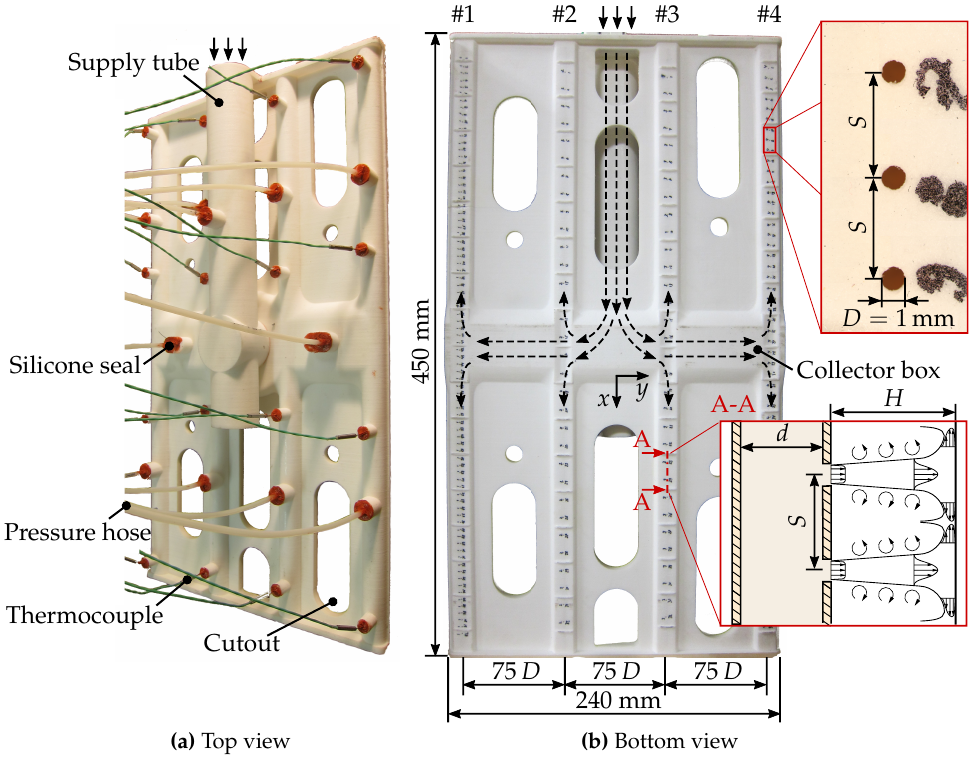
Figure 1. Top and bottom view of the laser-sintered panel model including a schematic illustration of two impinging jets.